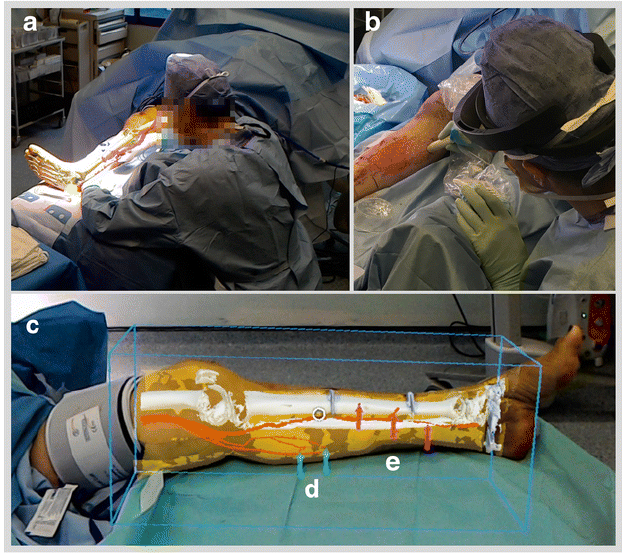
Figure 1. Use of HoloLens augmented reality (AR) goggles during operation in order to increase the accuracy of incision during a lower limb procedure. ( a ): remote view of AR through HoloLens. ( b ): Confirmation of perforator vein location. ( c ): Bound box overlay with ( d ) arrows pointing at medial sural veins and ( e ) arrows pointing at posterior tibial perforators.